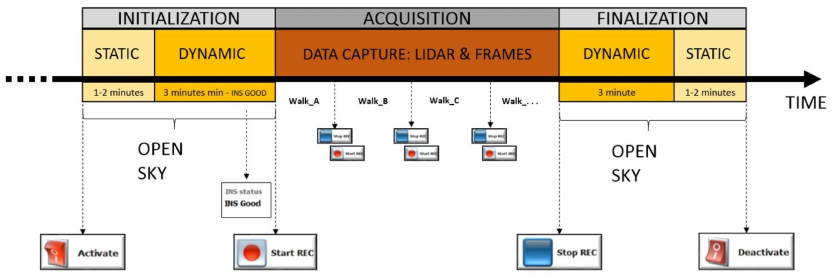
Figure 5. Initialization of the MMS